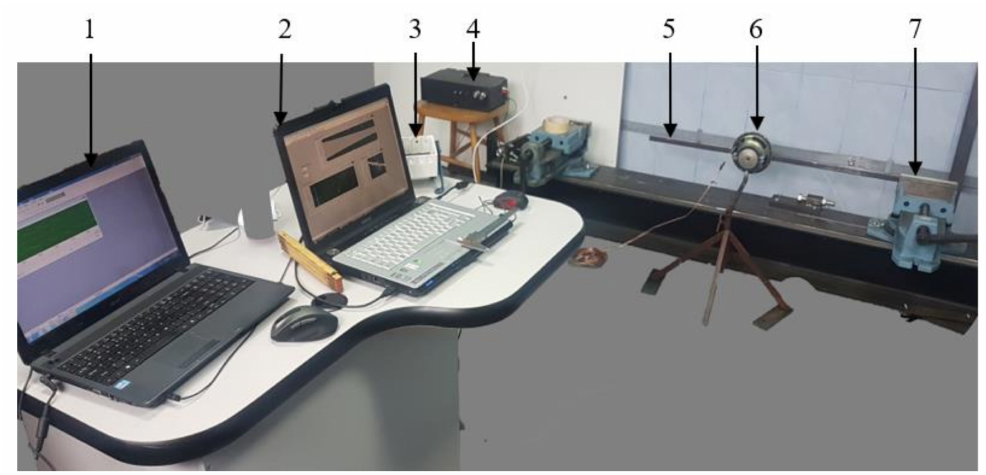
Figure 12. Experimental setup.